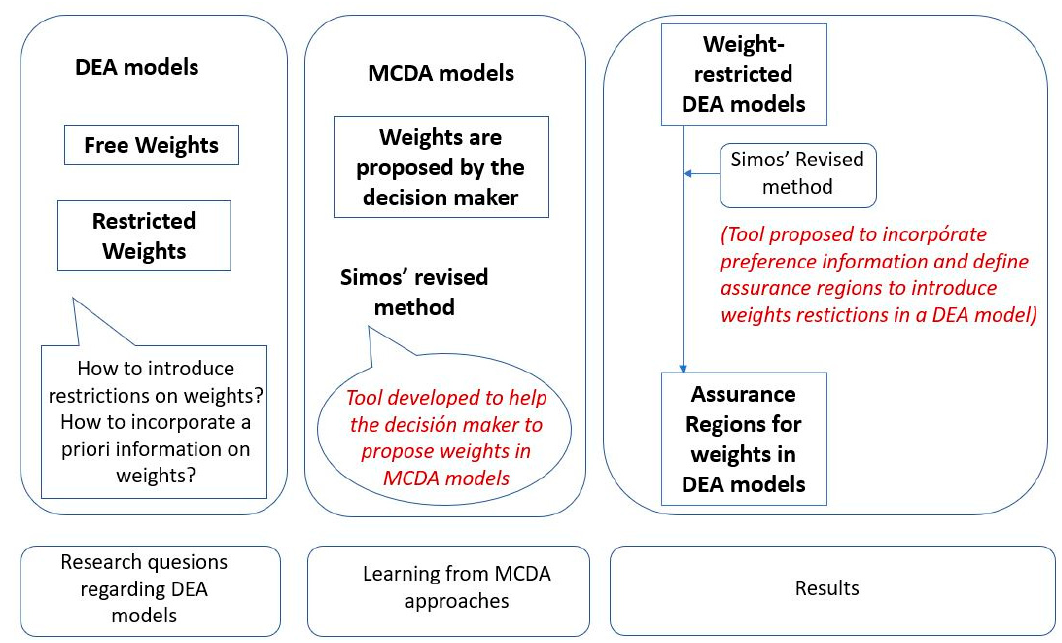
Figure 1. Graphical abstract of the theoretical framework and applied